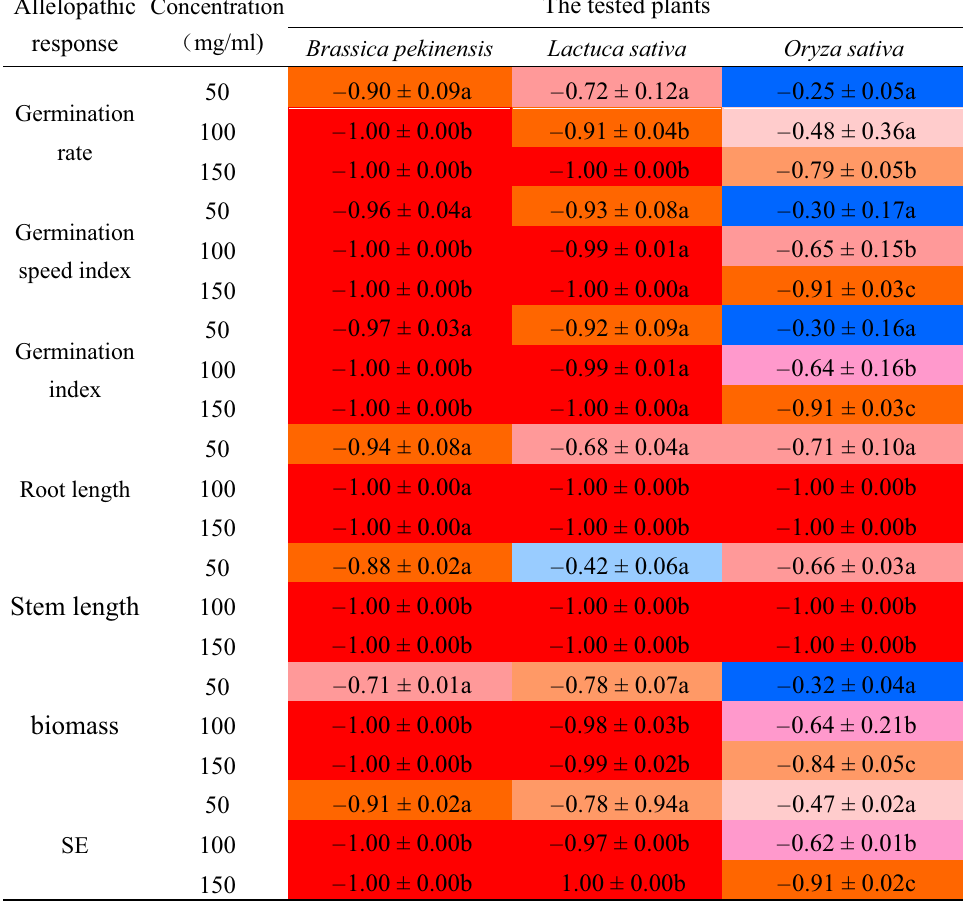
Table 2. Allelopathic response indexes of the water-cooled extract of A. argyi on different tested plants. (The color is near to deep red, it means that the Allelopathic response indexes is closer to - 1; the color is near to deep blue, it means that the Allelopathic response indexes is closer to 0. Different letters in the same column showed significant differences, with a significant level of